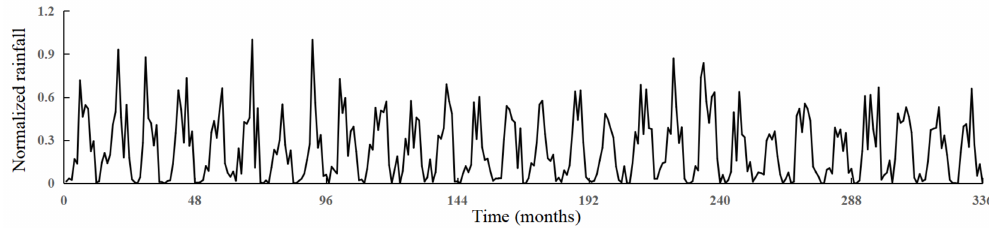
Figure 5. Original sequence of